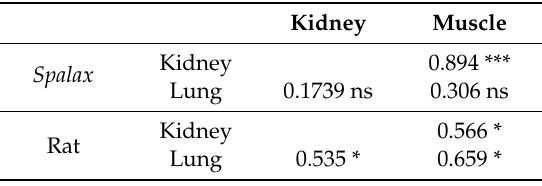
Figure 2. Relative telomere length (T/S ratio) in rat tissues. ( A ) range of relative telomere length (rTL) between all tissues ( N = 16, p < 0.0001); ( B ) rTL as a function of age in kidney (slope = − 0.08224, F 1,16 = 13.78, p < 0.01, R 2 = 0.4627), in lung (slope = − 0.0752, F 1,15 = 38.54, p < 0.0001, R 2 = 0.7199) and in muscle (slope = − 0.03385, F 1,14 = 26.37, p < 0.01, R 2 = 0.6532); ( C ) correlation between lung and muscle telomeres ( p = 0.0395, r = 0.659); ( D ) correlation between kidney and muscle telomeres ( p = 0.0278, r = 0.566); ( E ) correlation between kidney and lung telomeres ( p = 0.0142, r = 0.535). Table 3. Telomere length correlation among tissues.